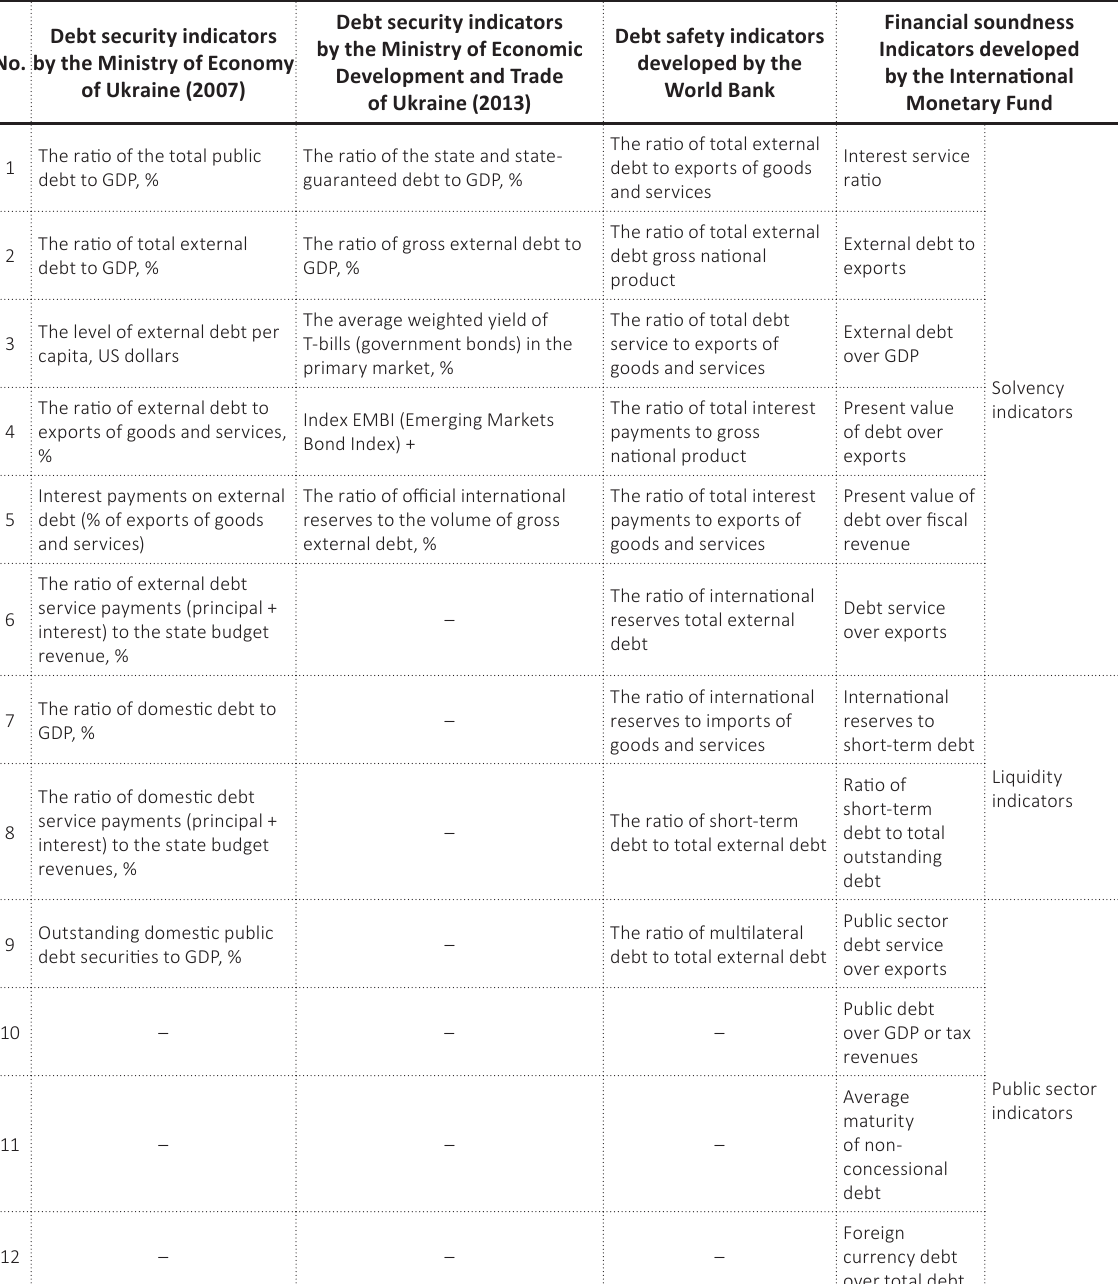
Table 1. Comparison of the approaches to the government debt security indicators’